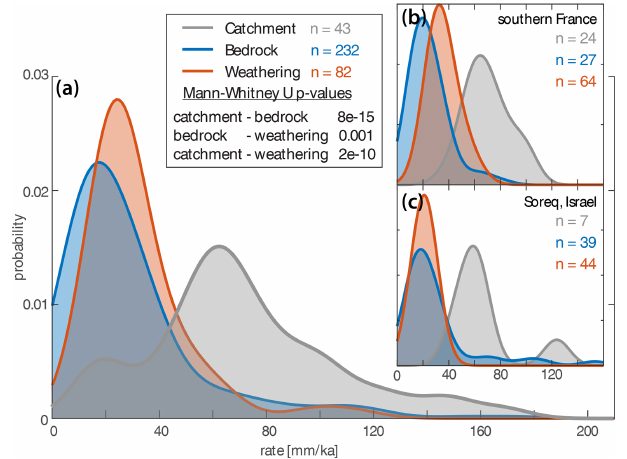
Figure 2. (a) Kernel density plot of weathering, bedrock, and catchment-averaged denudation rates in carbonate catchments for all compiled data. The legend also displays the results from the non- parametric Mann–Whitney U tests, where a low p value indicates a difference in the median value. (b, c) The same plots for south- ern France and the Soreq catchment in Israel; the only two regions where all three data types are